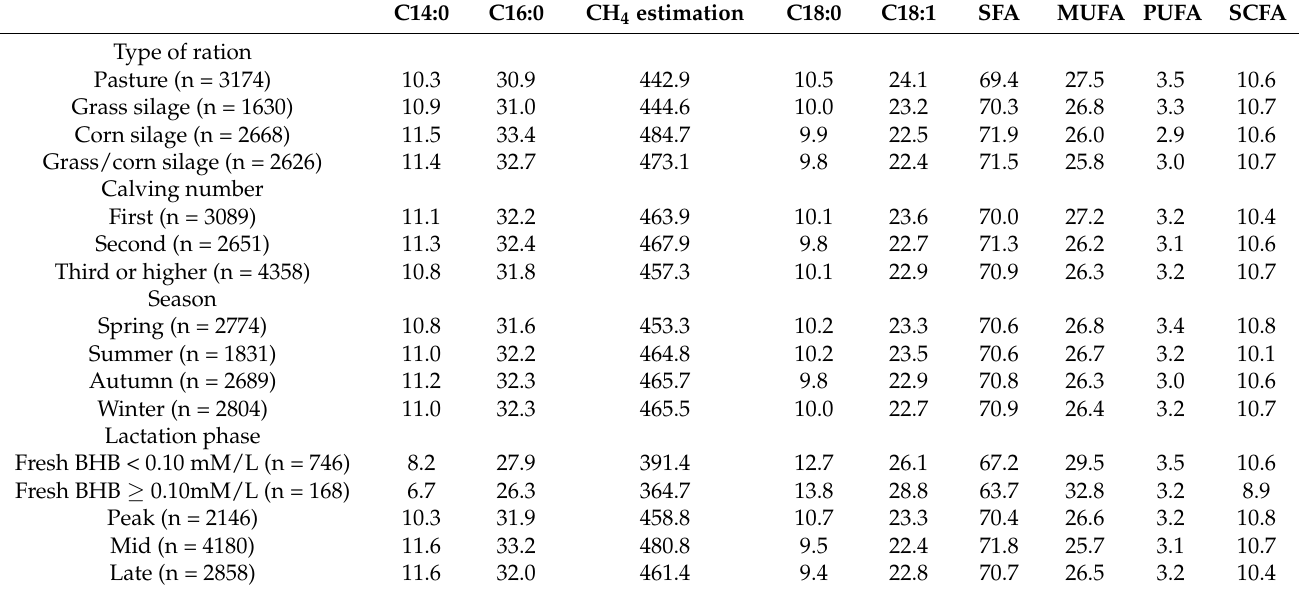
Table 3. Mean concentrations of myristic (C14:0), palmitic (C16:0) (and estimated CH 4 emission), stearic (C18:0), oleic (C18:1), saturated (SFA), monounsaturated (MUFA), polyunsaturated (PUFA) and short chain fatty acid (SCFA) (g/100 g fatty acids) (dependent variables) in milk samples from dairy cows in Galicia (NW Spain) by type of ration, calving number, season and lactation phase (explanatory variables). The number of records for each category of the explanatory variables is also provided (n).